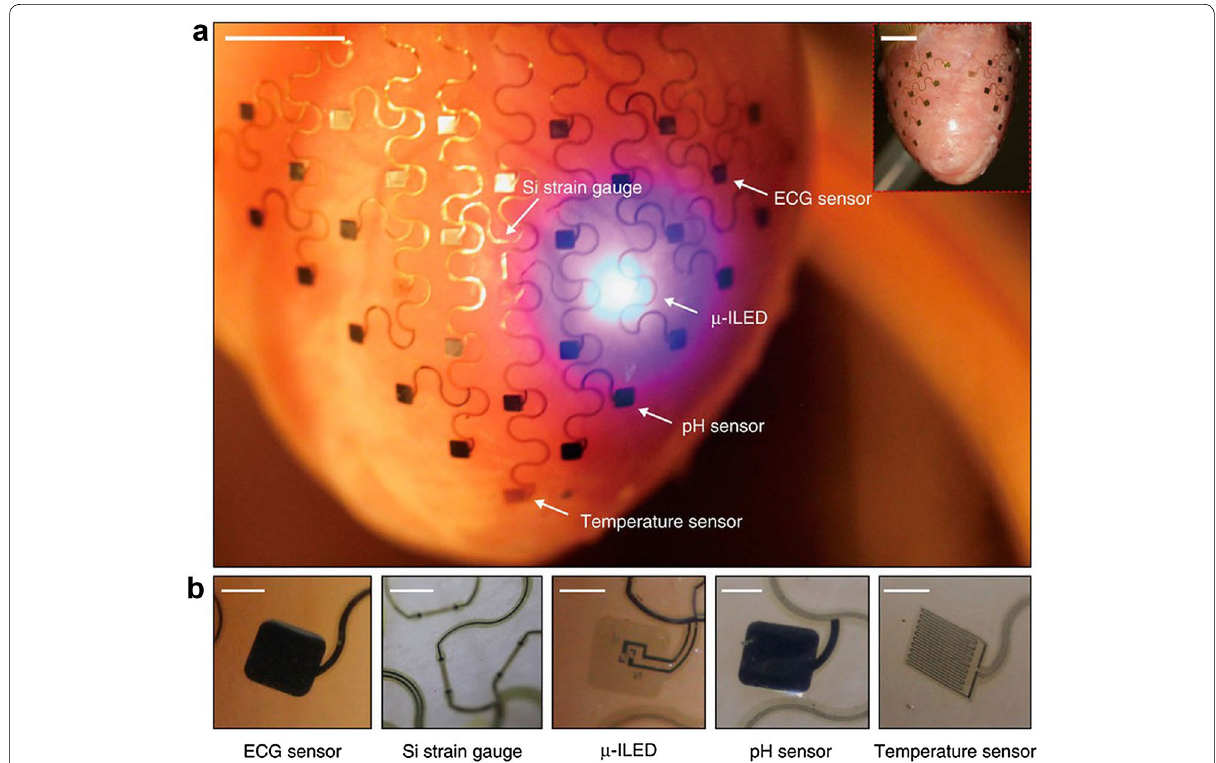
Fig. 3 3D‑MIMs a 3D‑MIM attached to the outer wall of the heart ( white arrows indicate the positions of the sensors with different functions). Scale bars 6 mm. b An enlarged image of sensors with each function. Scale bars 500 mm (Reproduced with permission from Ref. [36], Copyright © 2014,